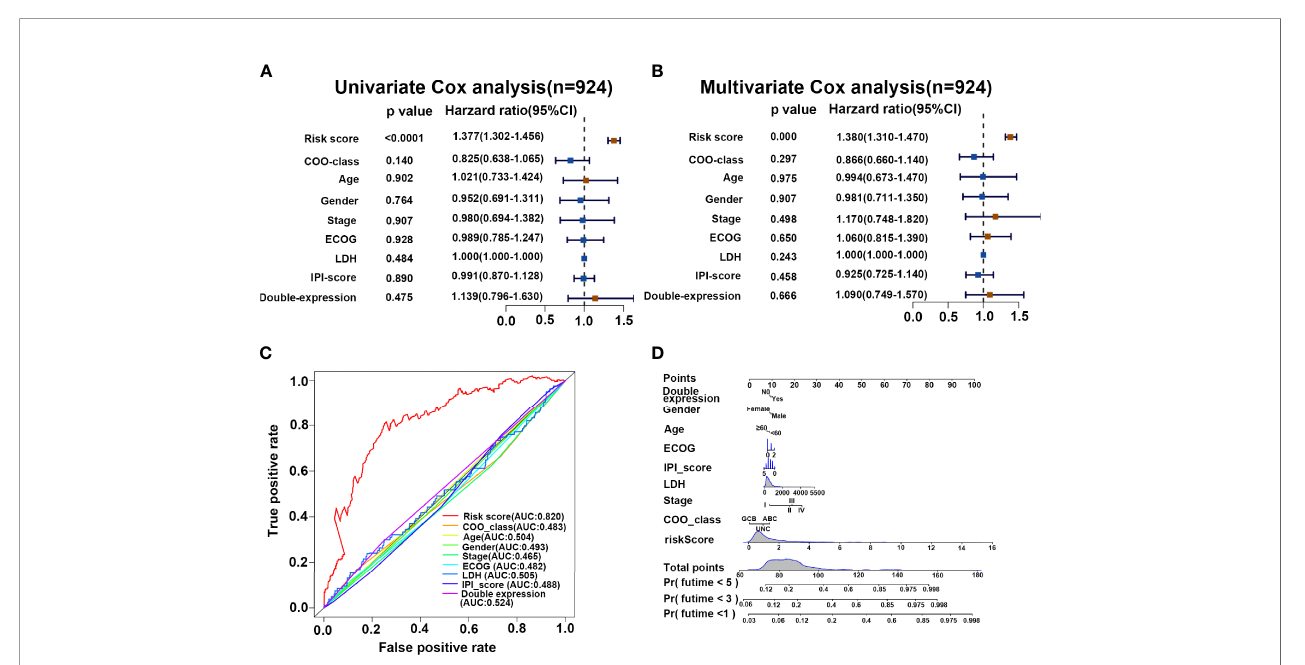
FIGURE 6 | Risk score is a superior biomarker for evaluating the prognosis of DLBCL. (A, B) Forest plot summary of the univariate and multivariable analyses of risk score and other clinical parameters. (C) ROC analysis of risk score and other clinical parameters. (D) Nomogram integrating the risk score and clinical parameters for predicting the probability of patient mortality at 1, 3, and 5 years of OS.